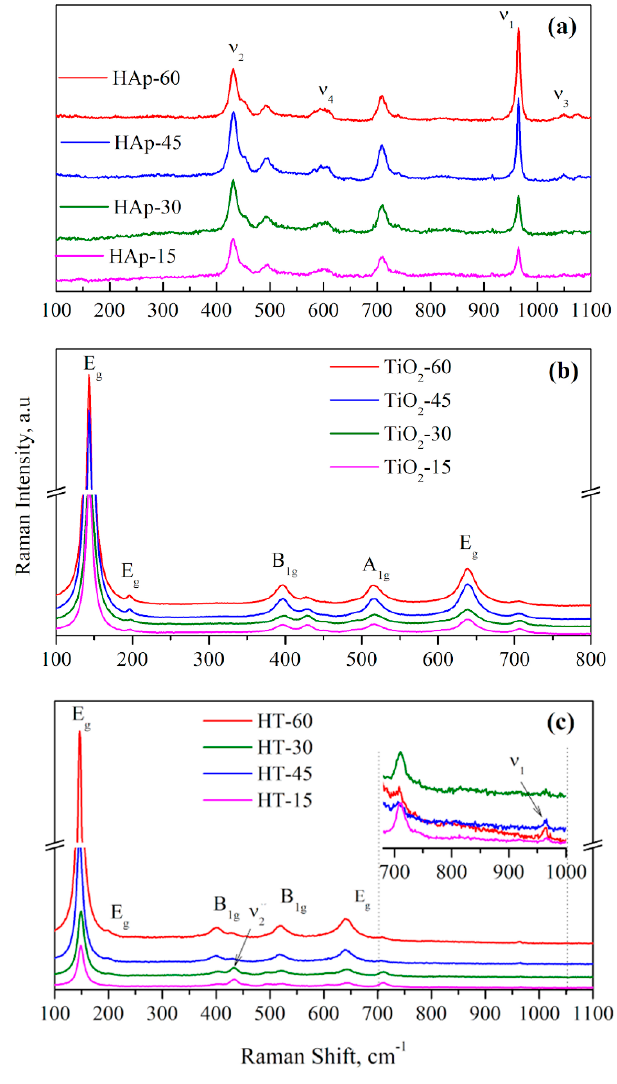
Figure 5. Raman spectra at different time intervals of ultrasound irradiation (15, 30, 45, and 60 min) ( a ) HAp, ( b ) TiO 2 , and ( c ) HT.